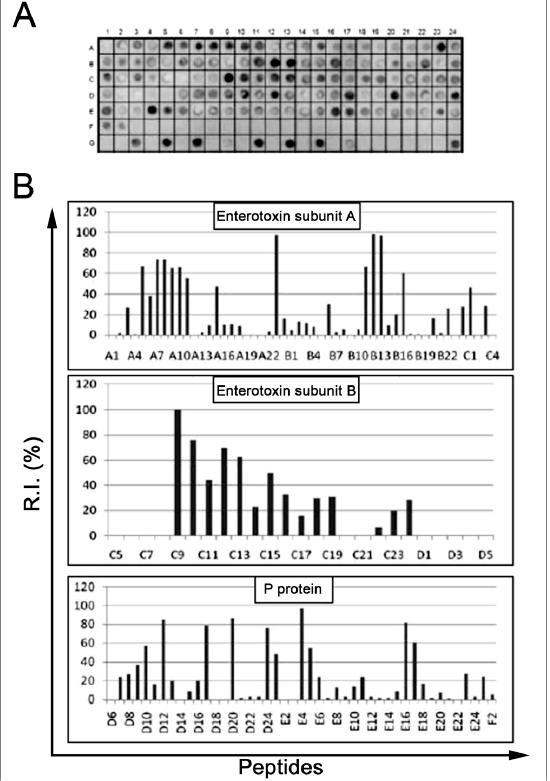
Figure 1. Fine epitope mapping of Vibrio cholerae toxin A (P01555), B (P01556), and P (P29485). A membrane-bound peptide library representing the three chains of the toxin was probed with a pool of vaccinated mouse sera (n = 15), and reactivity was detected using goat anti-mouse IgG alkaline phos- phatase alkaline labeled secondary antibody and chemiluminescence substrate. Panel ( A ) presents an image of the peptide array showing reactivity as dark circles. The panels in ( B ) graphically present the percent signal after normalizing the signals to the positive and negative controls. The sequences of peptides in each position are listed in Supplementary Figure